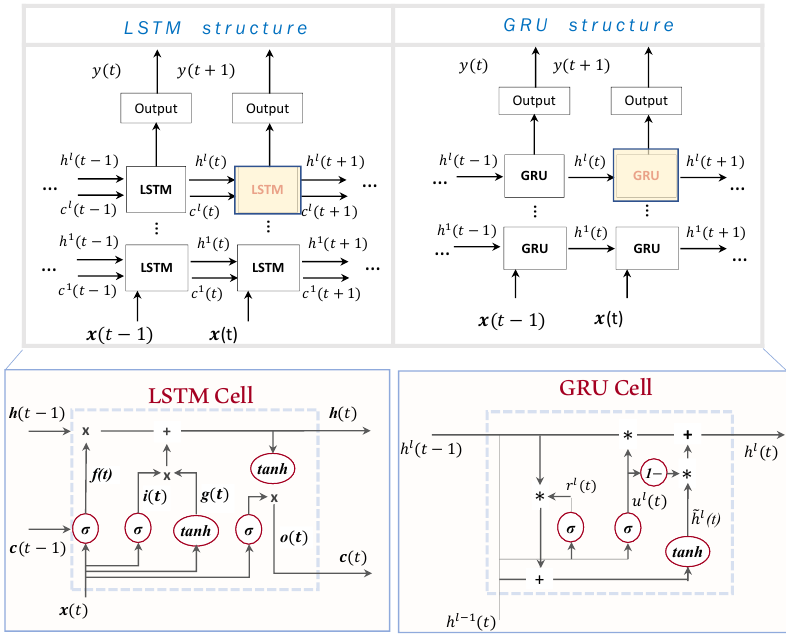
Figure 3. Comparison between the LSTM and GRU